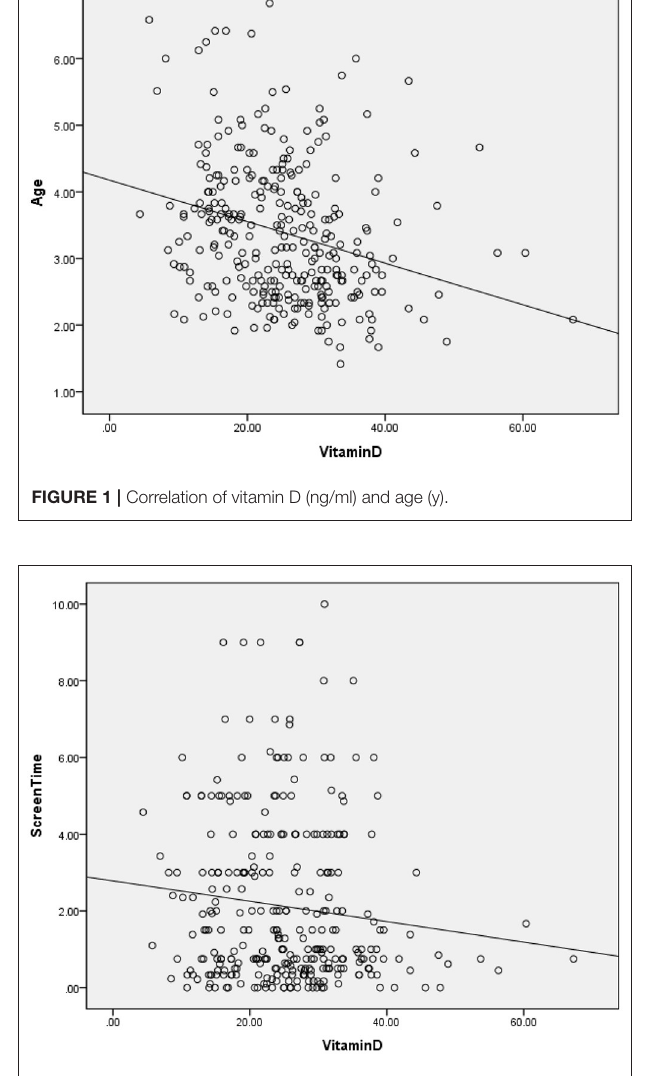
FIGURE 2 | Correlation of vitamin D (ng/ml) and screen time (h).